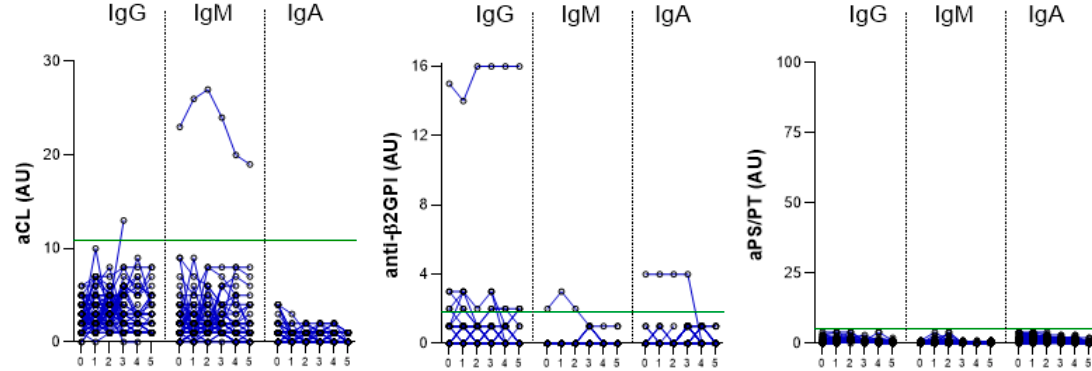
Figure 2. Longitudinal trends of aCL, anti- β 2GPI, and aPS/PT, IgG, IgM, and IgA before (0) and after vaccination (time points: 1—3 weeks after vaccination, 2—3 months after vaccination, 3—6 months after vaccination, 4—9 months after vaccination, and 5—3 weeks after the third booster dose). The blue lines connect the aPL levels of the individual HCPs. Values above the green line (99th percentile of healthy blood donors) are considered positive. Table 4. Longitudinal data from HCPs who developed aPL during the observation period after